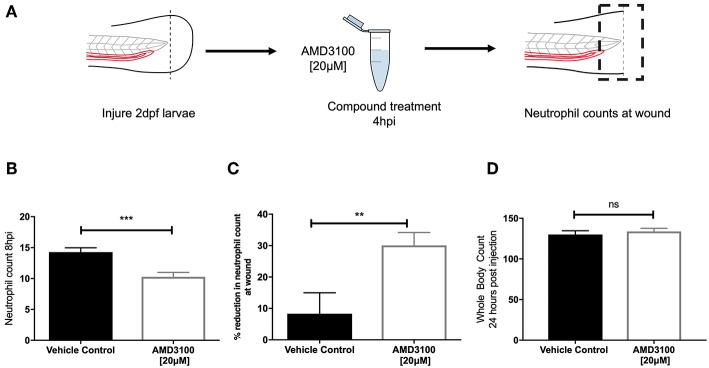
Inhibition of CXCR4 using AMD3100 accelerates inflammation resolution. (A) Experimental schematic of inflammation resolution experiments with AMD3100 compound treatment. (B) Number of neutrophils at the wound site in injured 2 dpf mpx:GFP larvae treated with AMD3100 or vehicle control at 8 hpi. Groups were analyzed using an unpaired t-test, ***p < 0.0002, n = 55 larvae from 5 independent experiments. (C) Resolution of the neutrophil component of inflammation for larvae treated with vehicle control or AMD3100. Groups were analyzed using an unpaired t-test, **p < 0.008 n = 32 larvae from 3 independent experiments. (D) Whole body neutrophil counts in 3 dpf mpx:GFP larvae 24 h post administration of AMD3100 or vehicle control. Groups were analyzed using an unpaired t-test, n = 26 larvae from 3 independent experiments.